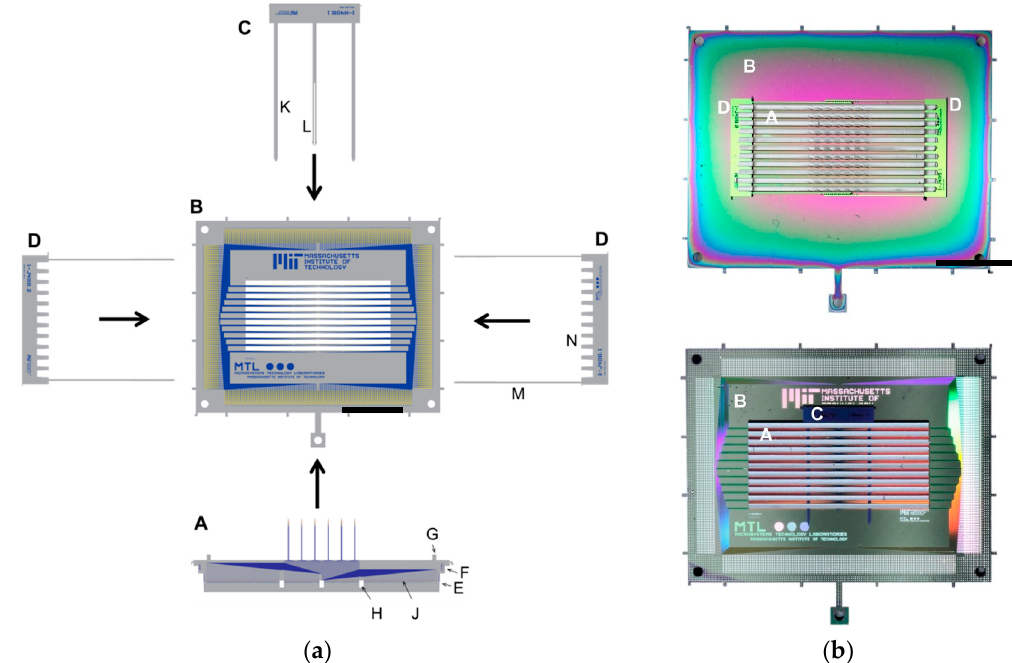
Figure 2. ( a ) Principle of the mechanical assembly for the probe shown in Figure 1. The 2-D inserts (A) are slid into the openings in the holder plate (B). A slight taper (E) on the 2-D insert facilitates the hand-assembly and a small bump (G) protects the shanks when pushing the 2-D inserts down with tweezers. On the bottom, a self-locking hook (C) with two guide beams (K) and locking beams (L) is then pushed through the openings in the 2-D inserts (H). A pair of self-locking alignment structures (D) is inserted on the top. Its tapered combs (N) push the 2-D inserts (A) into alignment and lock themselves into place: vertically confined by an indent (F) and horizontally by interlocking beams (M). The recording sites on the 2-D insert are wired down to the contact pads (J) and are described in the electrical assembly section. The fabrication steps for the individual parts are shown in Figures 3 and 4. ( b ) The top and bottom photographs show an assembled device from above and below, respectively, with the individual components labeled. Scale bars are 10 mm. A typical step-by-step assembly sequence is: (step 1) lay out the individual components for assembly, (step 2) grip holder plate (B) with reverse tension tweezers, (step 3) sequentially pick up the inserts (A) with fine tweezers and insert through the slots in (B), (step 4) inspect and tap down with tweezers onto the inserts to make sure they are fully inserted into the holder plate, (step 5) pick up the self-locking hook (C) with fine tweezers and insert the guide beams (K) through the openings of the inserts (H). It can help to lift the reverse tension tweezers with the probe to better see, or place a mirror below the probe for visual guidance. (step 6) once the guide beams are inserted, use either tweezers or your finger to gently push the hook through completely. As the guide beams pass through each insert, a small resistance can be felt when pushing, due to the hooks (L) going through the openings (H) of each insert. (step 7) using tweezers, pick up the two alignment structures (D) and place on the top side of the probe body (B), roughly aligning them. (step 8) using two sets of tweezers, one in each hand, push the two structures (D) closer until they slide into position. The tweezers should be open in this step, allowing both pushing and rotating of the two parts (D) as they approach and lock. Avoid pushing both parts forward at the same time but alternate between them. Use your dominant hand for the last fine push that locks the beams of (D) together and aligns the probe.